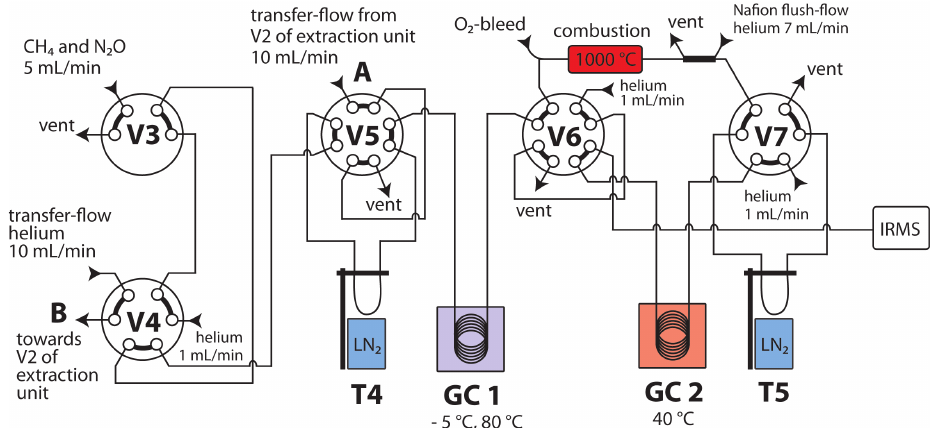
Fig. 2. Flow scheme of the GC-C-GC-IRMS unit. The letters A and B show the valve ports that connect to the ports A and B of the ice extraction unit, respectively. The CH 4 and N 2 O sample is delivered to port A of the GC-C-GC-IRMS unit by the helium stream that flows out of the GC-C-GC-IRMS unit at port